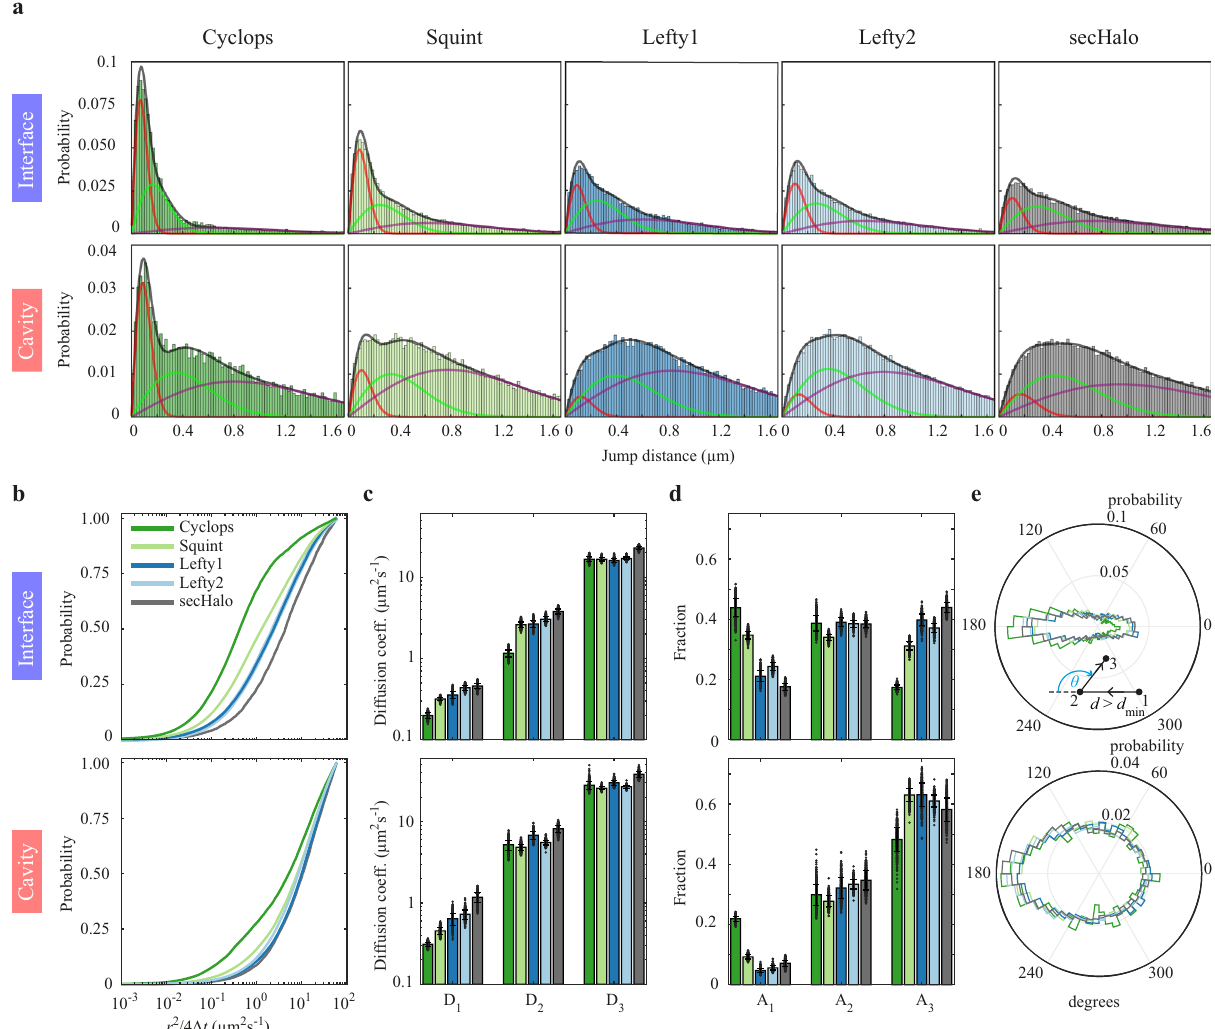
Fig.3|Mobilityofmorphogensincell-cellinterfacesandextracellularcavities. a Distribution of jump distances within single-molecule tracks in interfaces and cavities for the indicated morphogen and sec-Halo. Lines represent a three- component diffusion model (black) and the individual components (red, green, purple). b Cumulativedistributionsofjumpdistances. c) Diffusioncoef fi cientsand